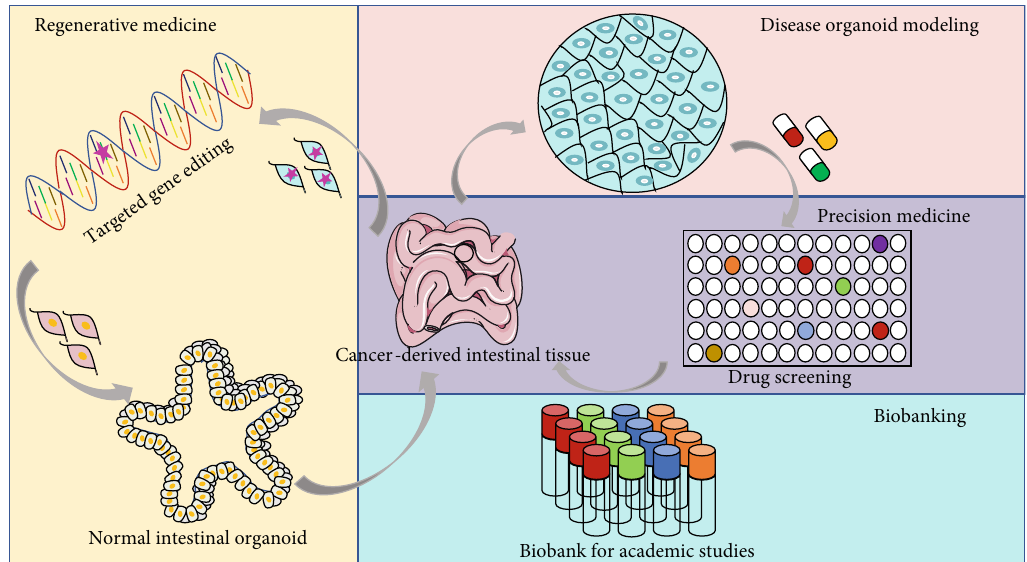
Figure 2: Multiple applications of organoid technology: (1) regenerative medicine; (2) disease modeling; (3) precision medicine; (4)